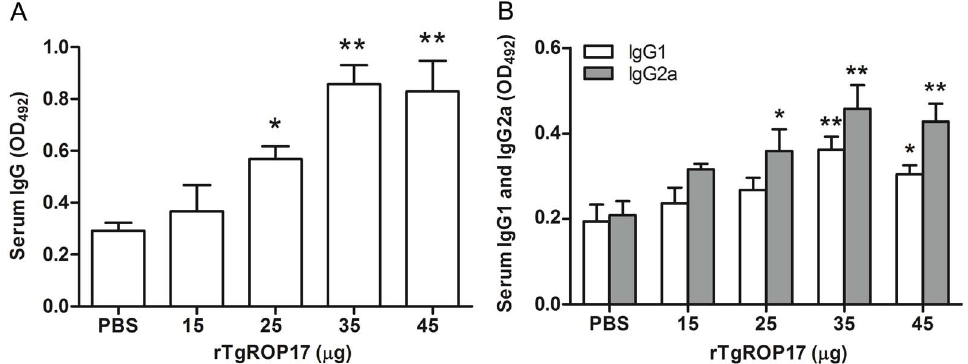
Figure 2. Determination of specific anti-rTgROP17 antibody responses in serum samples from vaccinated and control mice by ELISA. The levels of both specific total IgG (A) and IgG isotype (B) antibodies in the sera of the BALB/c mice were determined by ELISA with rTgROP17 as the bound target two weeks after the final immunization. The results are expressed as the mean value 6 SD of OD 492 (n=8) from three independent experiments. * P , 0.05, ** P , 0.01 relative to PBS control groups.